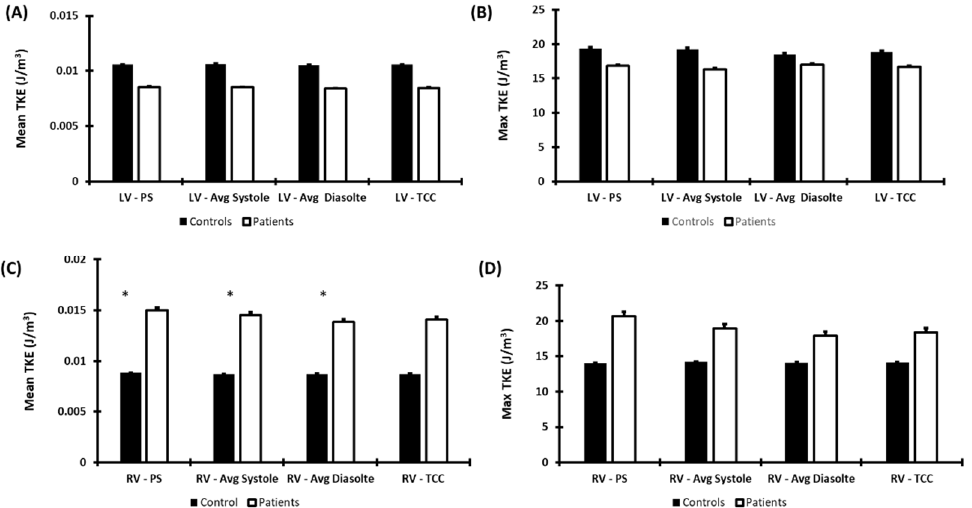
Figure 5. Turbulent kinetic energy in the left ventricle and right ventricle. Mean turbulent kinetic energy (TKE) and max TKE were calculated throughout the entire cardiac cycle, including peak systole (PS), average systole (avg systole), average diastole (avg diastole), and total cardiac cycle (TCC) in the Left Ventricle (LV) and Right Ventricle (RV) for both patients and controls. Panels ( A , B ) show the mean TKE and the max TKE in the LV throughout the entire cardiac cycle for controls and patients. Panels ( C , D ) show the mean TKE and the max TKE in the RA throughout the entire cardiac cycle for controls and patients. Statistical significance between the two cohorts was only observed in the RV at PS, avg systole, and avg diastole (*: p < 0.05).